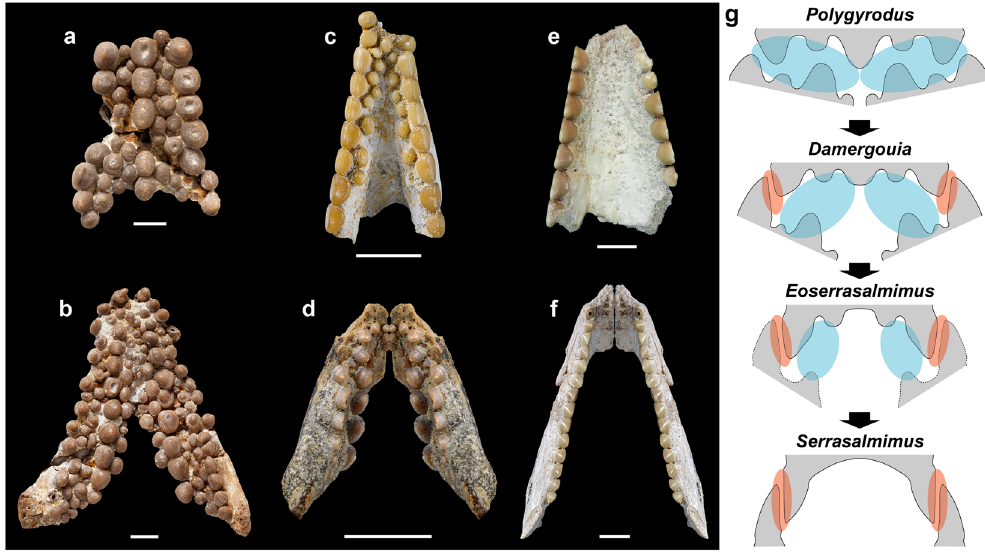
Figure 2. Jaw elements and dentitions of serrasalmimid fishes, and evolutionary shift from crushing to cutting function. (a , b) Polygyrodus cretaceus (Agassiz, 1843) from the Turonian of England, NHMUK PV OR 39048, vomer ( a ) and NHMUK PV P 11157, right and left prearticulars (and dentaries?) ( b ) in ventral and dorsal views, respectively. ( c) Eoserrasalmimus cattoi gen. et sp. nov. from the Maastrichtian of Morocco, MHNM KHG 165, vomer in ventral view. ( d) Damergouia lamberti gen. et sp. nov. from the Turonian of Niger, MNHN.F.HGS176, left prearticular (and mirror image for the right side) in dorsal view. ( e , f) Serrasalmimus secans gen. et sp. nov., OCP DEK-GE 701, vomer ( e ) and MHNM KHG 152, left prearticular ( f ) in ventral and dorsal views, respectively. ( g) Schematic diagram showing the evolutionary sequence of morphological and functional changes observed in serrasalmimid jaws. The jaws are shown in cross section and with teeth in occlusion; the morphology of the teeth has been simplified, and the shape of the unknown lower dentition of Eoserrasalmimus has been inferred from that of the upper dentition. Blue and red shadings indicate crushing and cutting surfaces, respectively. Note the rotation of the toothed surface of the prearticulars, from a nearly horizontal to a vertical position. Scale bars, 10 mm; sketches in ( g ) not to scale. ( a , b , copyright: The Trustees of the Natural History Museum, London – http://data.nhm.ac.uk; c , d , f , photographs by Lilian Cazes –